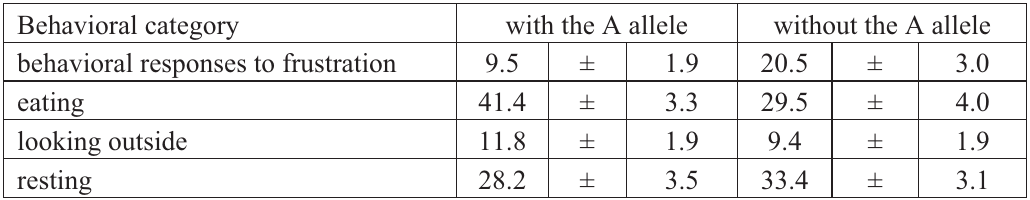
Table 1. Mean time budgets (% ± SE) of each behavioral category in horses with and without the A allele in DRD4